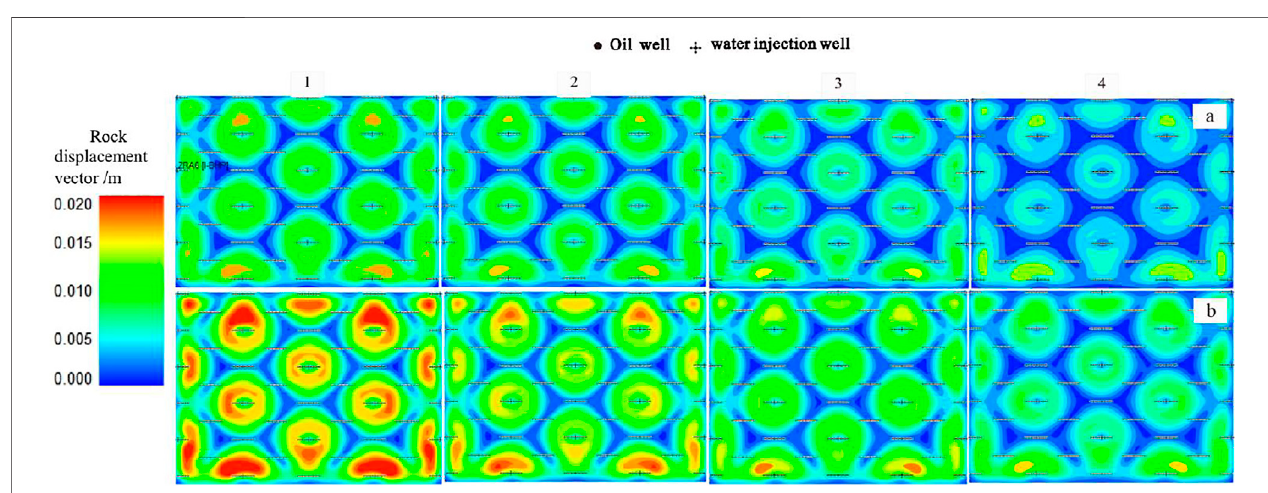
FIGURE 10 | Rock displacement vector diagrams based on different shear modulous values considering starting pressure gradient: (A) Pressure gradient is not considered, (B) Starting pressure gradient is considered.